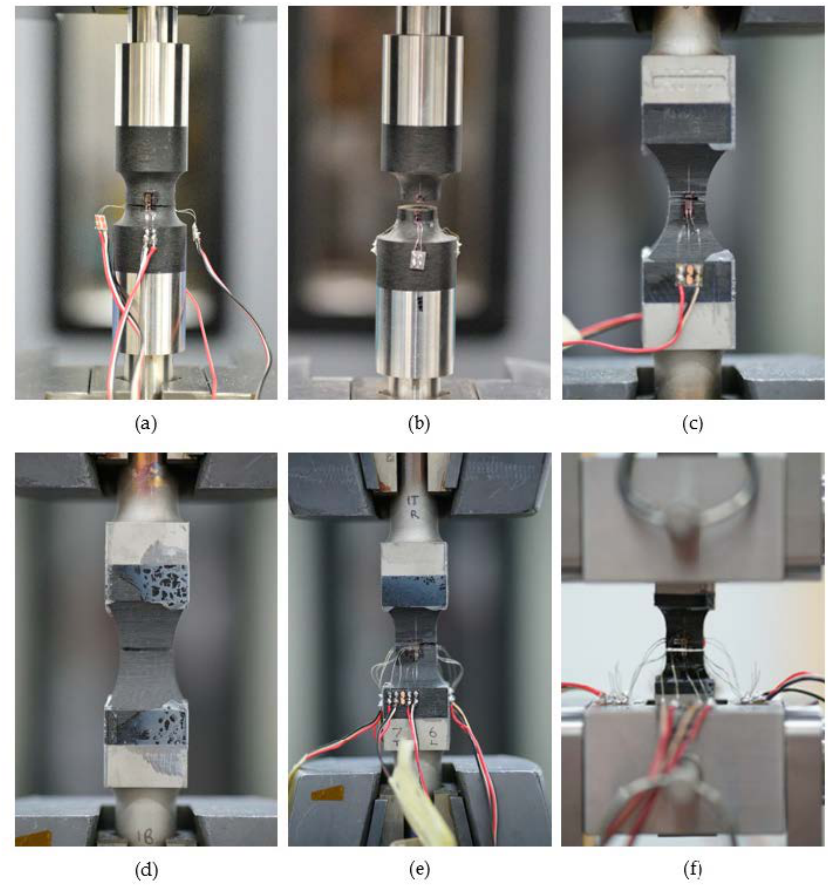
Figure 10. Failure images of direct geometries: ( a ) spool A, ( b ) spool B, ( c ) bi-lateral waist, ( d ) RARDE Type II, ( e ) RARDE Type III, and ( f ) RARDE Type III